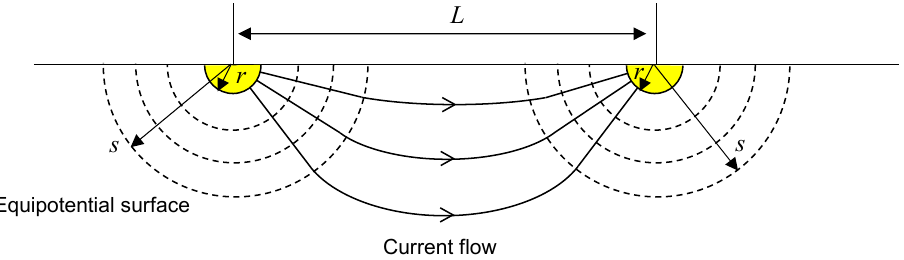
Figure 5. Definitions of the symbols and equipotential surface shape between two half-buried spherical electrodes.